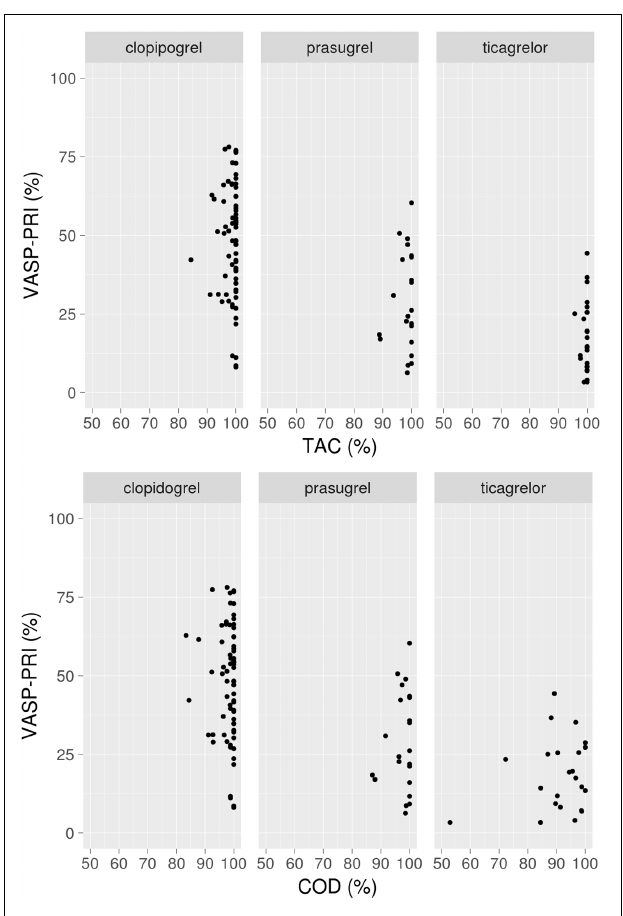
FIGURE 4 | Association between VASP-PRI at 6-months and taking adherence (upper) and correct adherence (lower) in the 30 days preceding the VASP-PRI assay. VASP-PRI, vasodilator-stimulated-phosphoprotein- phosphorylation-platelet-reactivity-index.